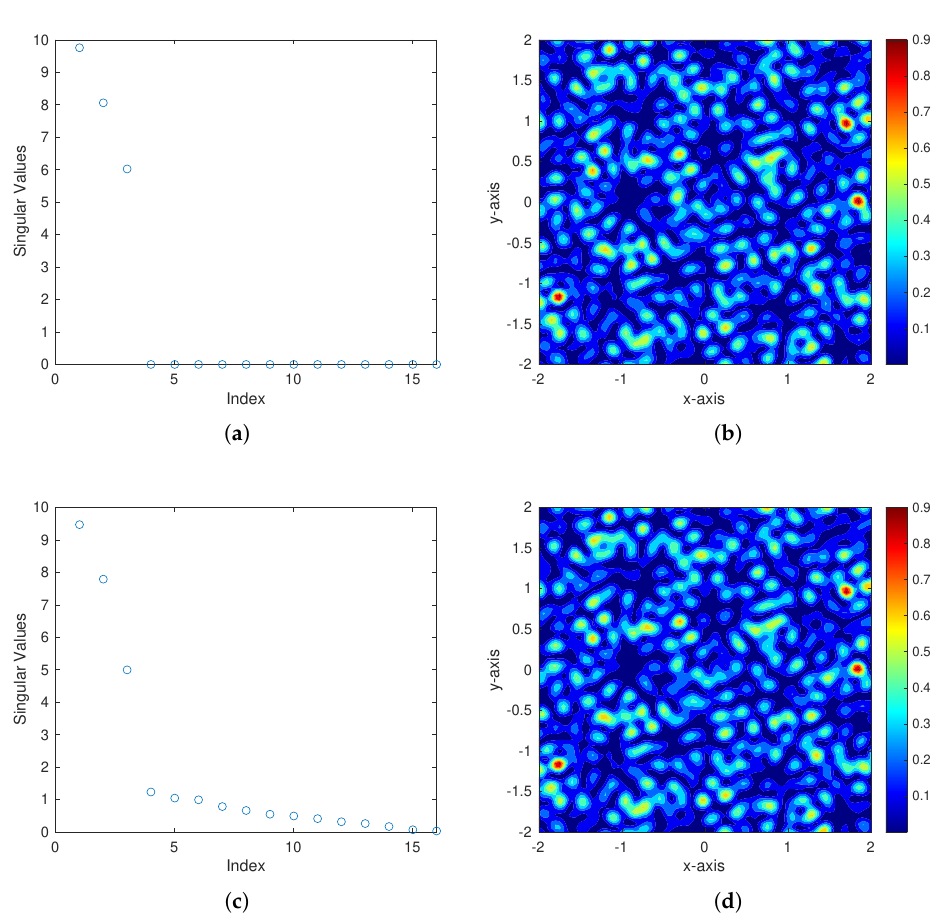
Figure 13. Singular value distribution and imaging results for the case with the smallest mean square error case among the test data. ( a ) SVD with true data; ( b ) imaging result with true data; ( c ) SVD with learning data; ( d ) imaging result with learning